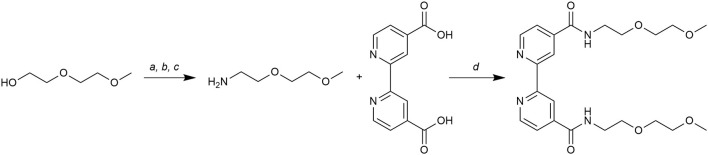
Synthetic route to bpydeg. Reactions and conditions: (a) TsCl, TEA, 0°C, 20 min, r. t., 18 h (82%); (b) NaN3, DMSO, r. t., 18 h (80%); (c) TPP, Et2O, 0°C, 1 h, r.t., 1.5 h; H2O r. t., 18 h (60%); (d) EDCI/HOBt, DMF, r. t., 30 h (77%).